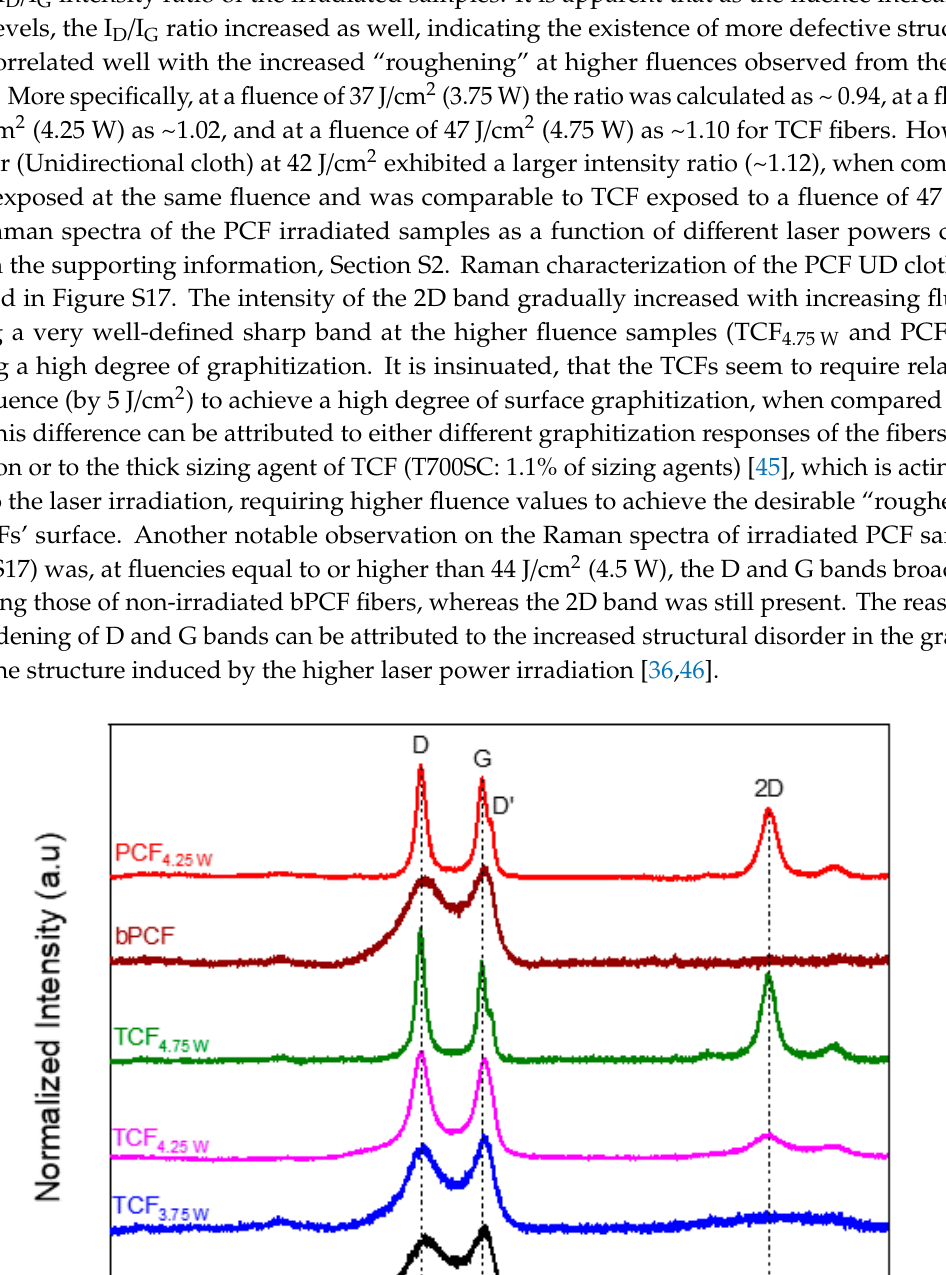
Figure 8. Fluence vs I D /I G intensity ratio of the irradiated samples.